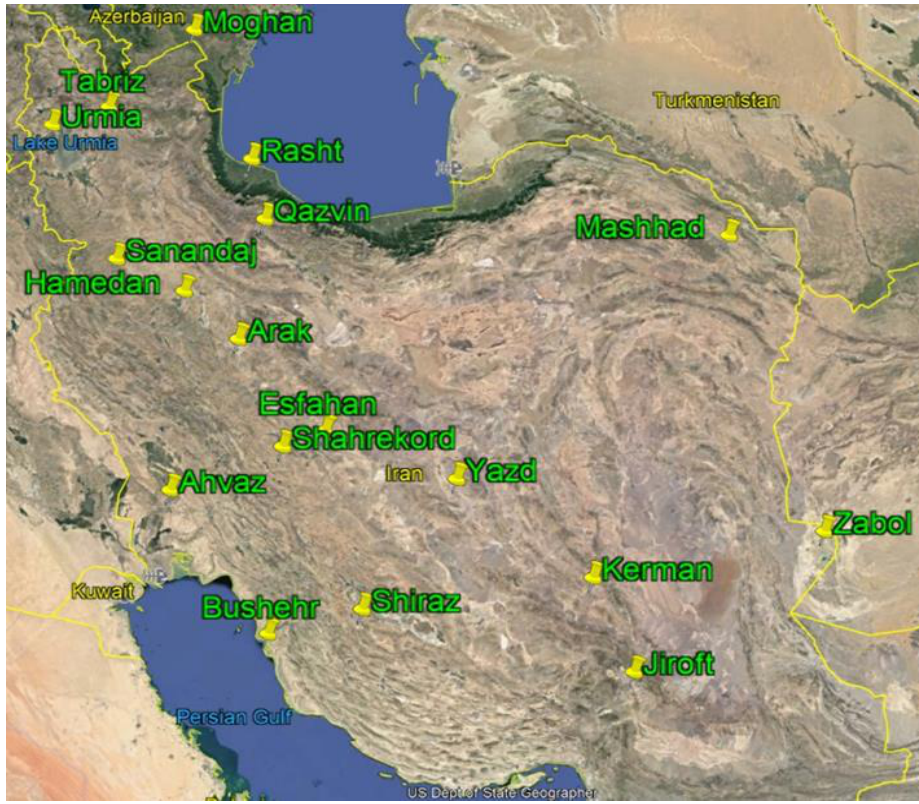
Figure 1. Location of the 18 study sites in Iran.